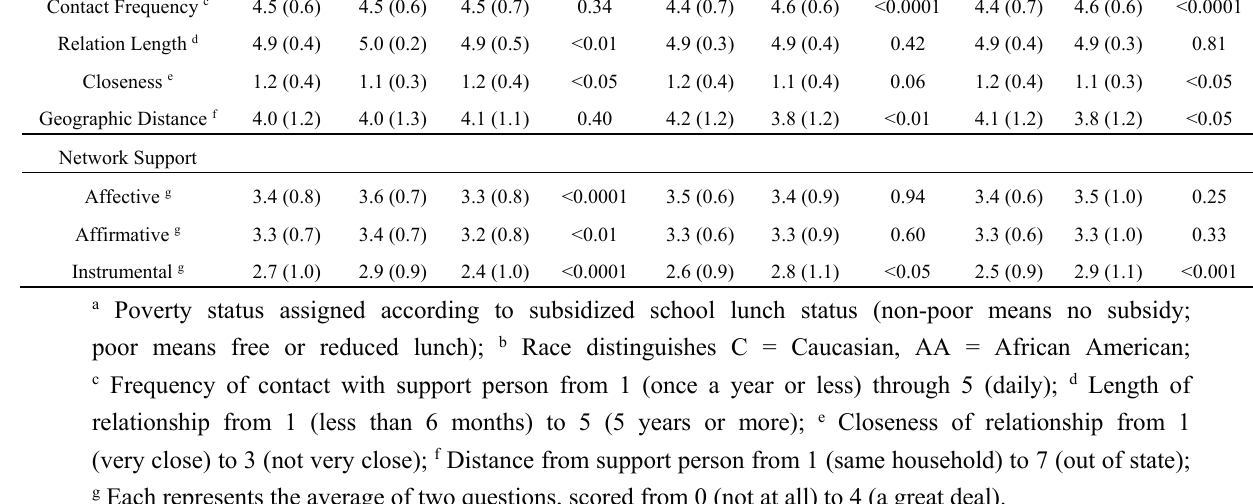
Table 2. Parent network characteristics by childhood ADHD risk status and